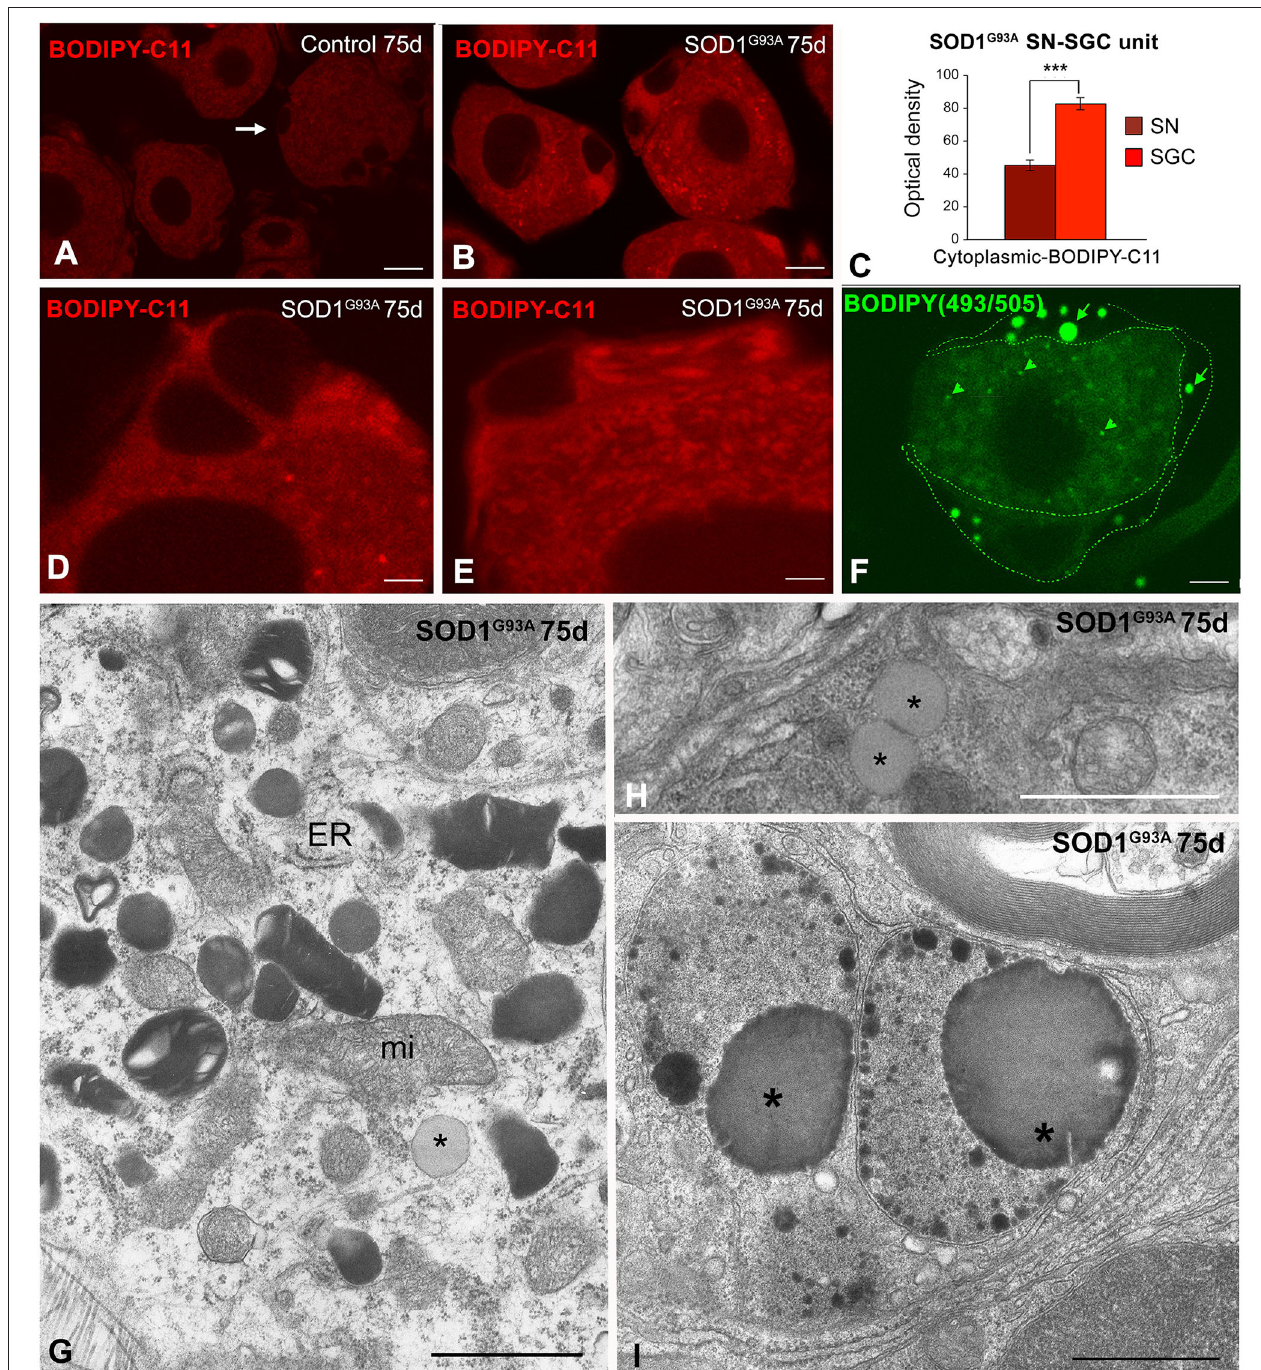
FIGURE 3 | (A–E) In situ determination of lipid peroxidation with the BODIPY-C11 probe in SN-SGC units from control (A) and SOD1 G93 mice (B,D,E) . (A) In control SN-SGC units both sensory neurons and SGCs (arrows) exhibit low fluorescent signal of lipid peroxidation in the cytoplasm. (B,D,E) Lipid peroxidation signal intensity notably increases in the cytoplasm of both sensory neurons and SGCs from SOD1 G93 mice, although BODIPY-C11 labeling was substantially higher in SGCs. Note the absence of fluorescent signal in the nucleus. (C) Densitometric analysis of the cytoplasmic BOBIDY-C11 fluorescent signal intensity in sensory neurons and SGCs from SOD1 G93 mouse at day 75 of age. (F) BODIPY-493/503 staining of a SN-SGC unit from the SOD1 G93 mouse at day 75 of age. Spherical lipid droplets of neutral lipids appear intensity labeled with the probe. Lipid droplets are larger and more abundant in SGCs (arrows) than in the sensory neuron (arrowhead). The limits of the SGC have been drawn with dashed green lines. (G) Ultrastructural image of the SGC cytoplasm from a SOD1 G93A mouse illustrating the presence of numerous lysosomes with a heterogeneous morphology, isolated cisterns of endoplasmic reticulum (ER), some mitochondria (mi) and a lipid droplet (asterisk). (H) Detail of two spatially associated lipid droplets (asterisks) in a SGC from the SOD1 G93 mouse. (I) Electron micrograph showing very complex lysosomal compartments that includes large lipid droplets (asterisks). Scale bar: (A,B,F) 10 µ m; (D,E) 5 µ m; (G,H) 1 µ m; (I) 2 µ m. Student t -test in (C) p < 0.001.